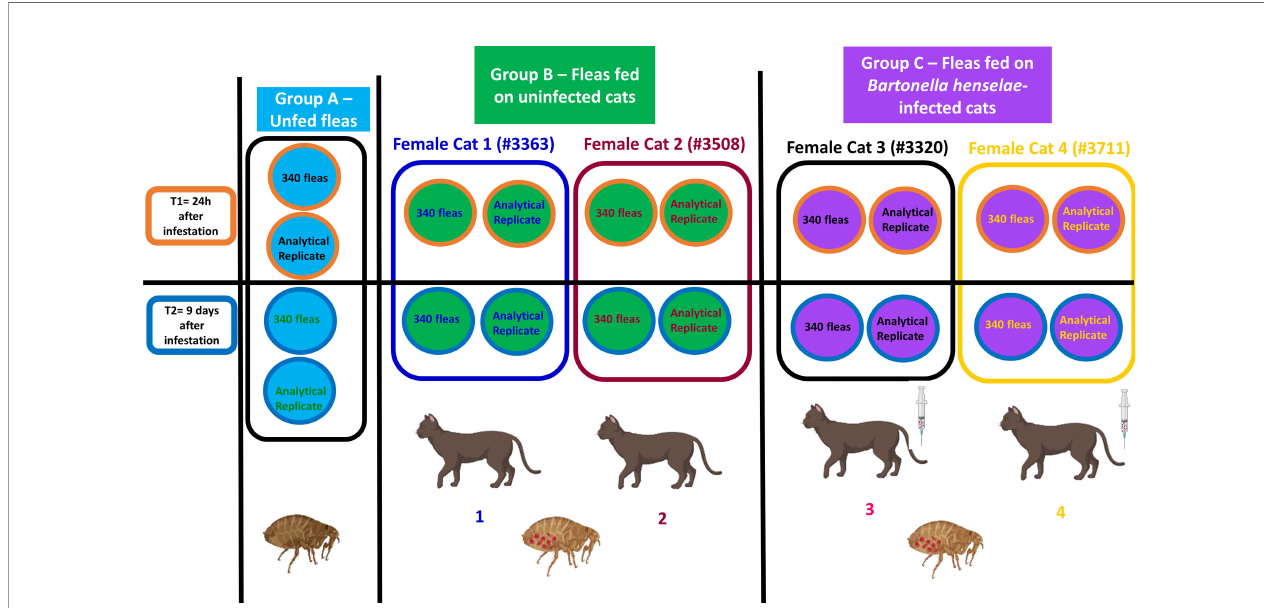
FIGURE 2 | Experimental design used in this study for investigation of differentially abundant proteins in (Group A) unfed fl eas, (Group B) fl eas fed on uninfected cats and (Group C) fl eas fed on B. henselae -infected cats. Fleas were collected from the cats at 24 hours and 9 days after infestation for proteomic analyses. Created with